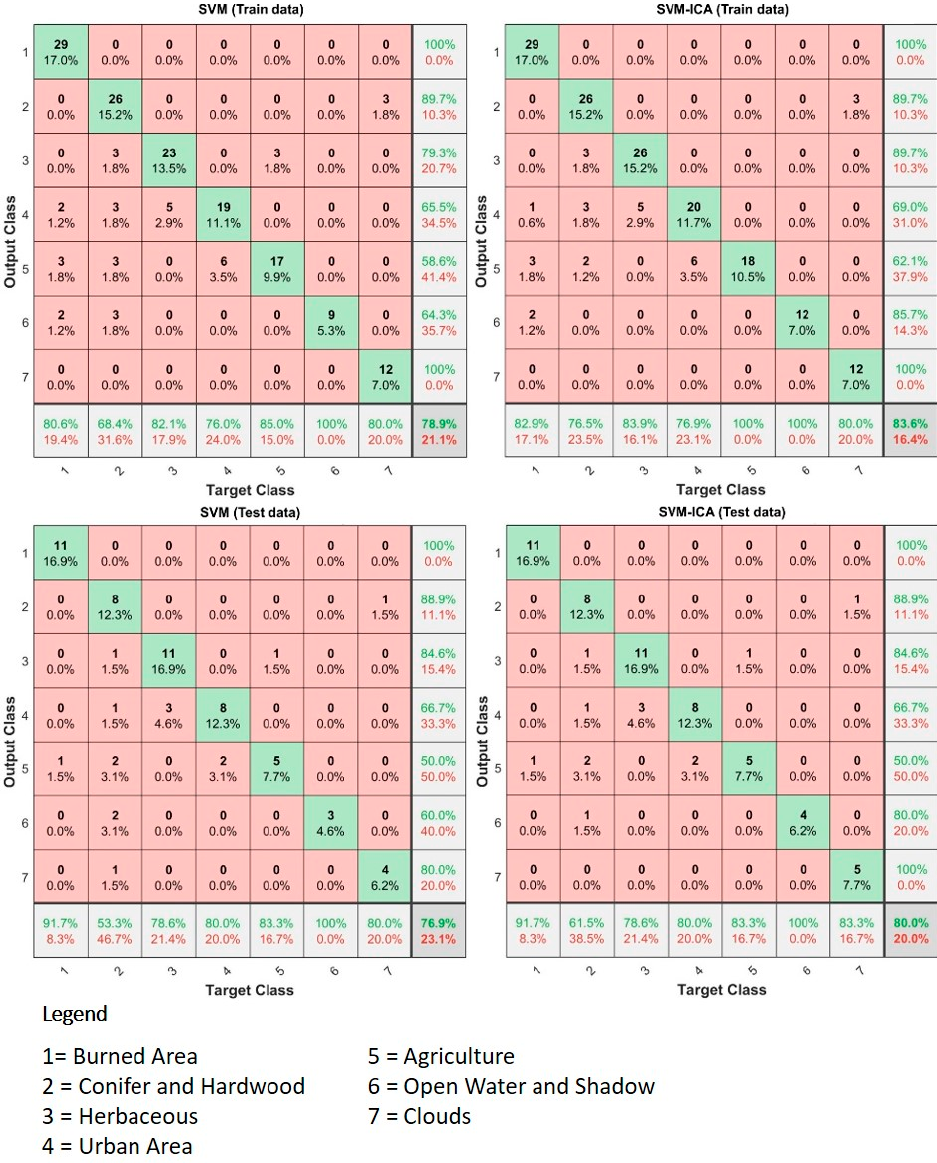
Figure 9. Overall accuracy of SVM results for classifying post ‐ wildfire occurrence from the Landsat ‐ 8